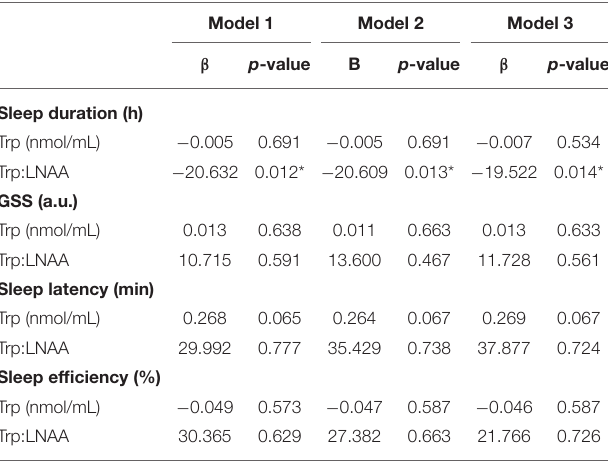
TABLE 5 | Association between sleep duration, global sleep score (GSS), sleep latency and sleep efficiency with plasma amino acids. Model 1 Model 2 Model 3